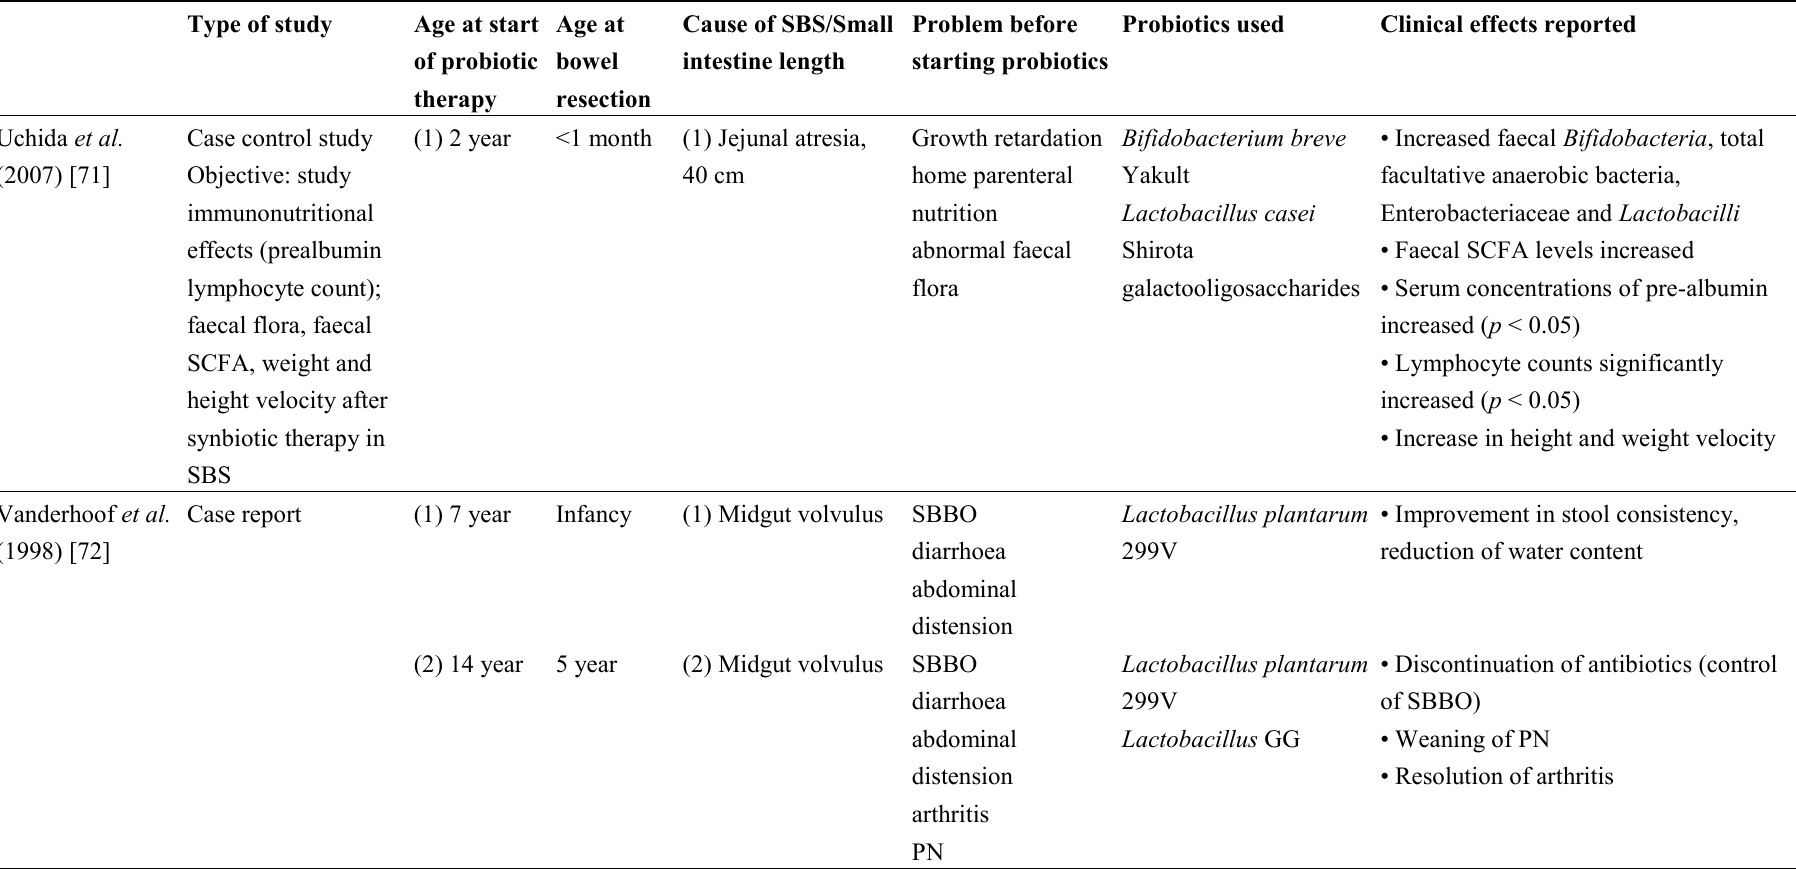
Table 4. Clinical effects of probiotics in